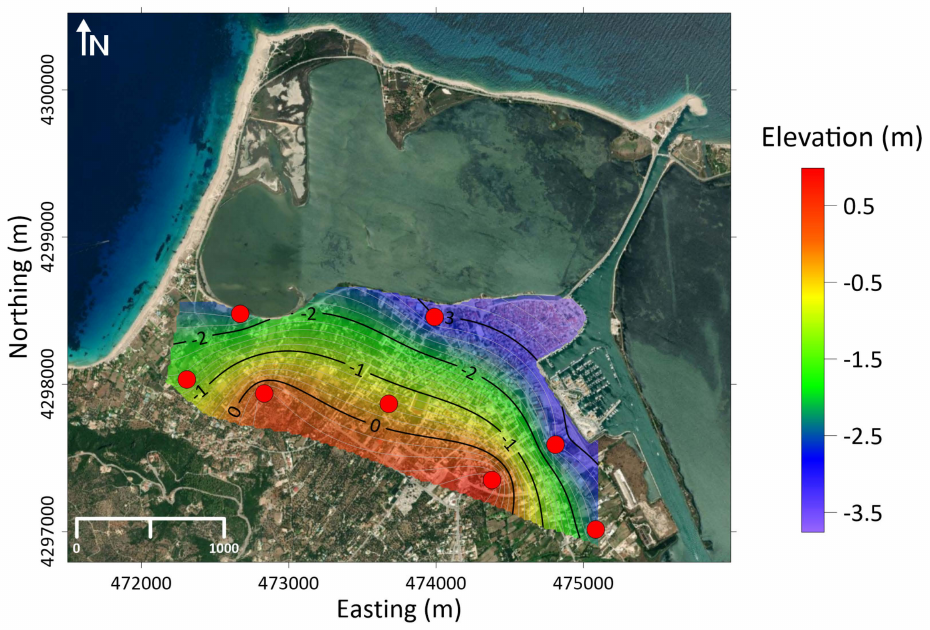
Figure 10. The absolute elevation of marl’s roof, based on interpretation of the geophysical measure- ments from Lefkada old